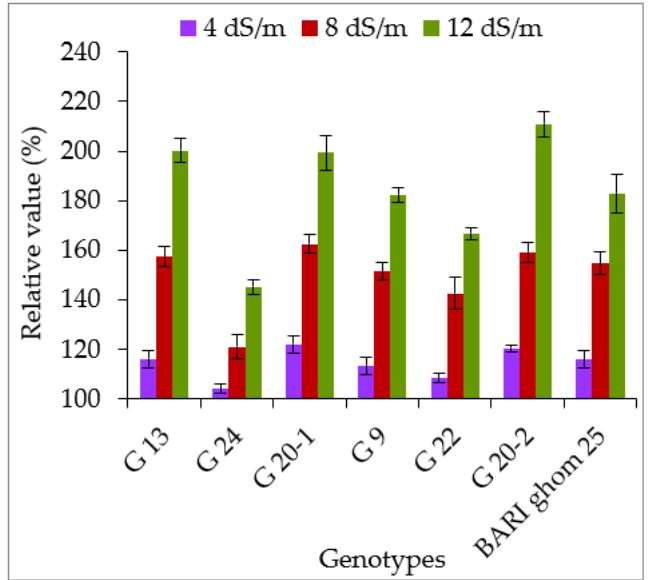
Figure 16. Relative value of soluble protein content in leaf of wheat genotypes under various salinity levels. The vertical bar indicates average data of five independent replicates ( n = 5). Error bars represent standard error.